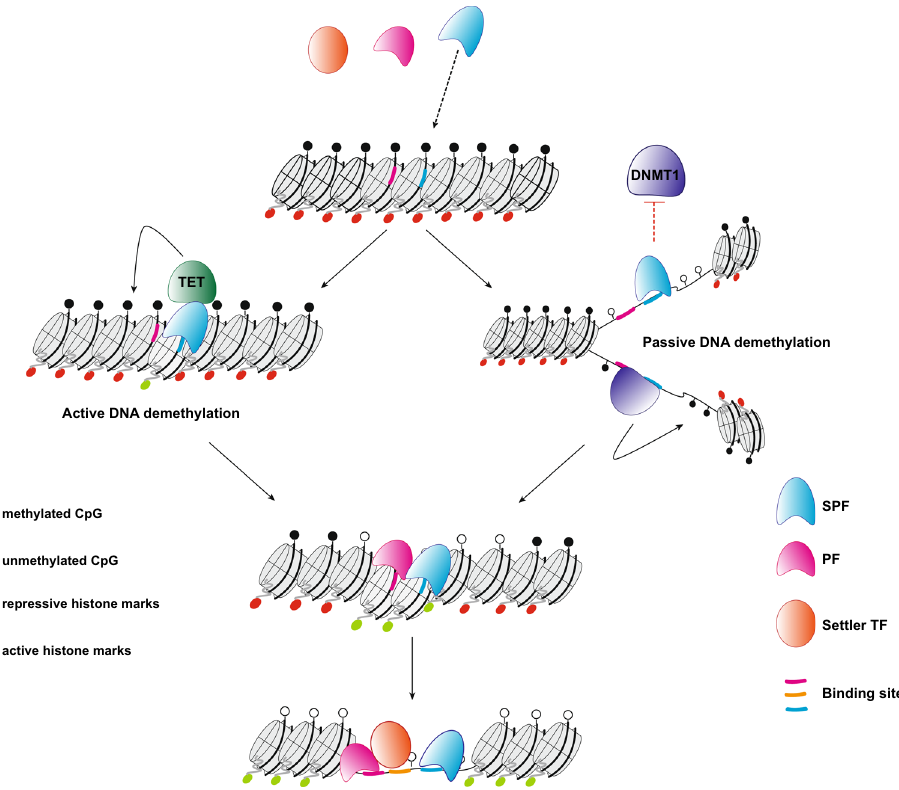
Fig. 8 Hierarchy of transcription factor binding. SPFs engage their target sequences in closed chromatin and in the presence of DNA methylation. Upon binding, most SPFs drive DNA demethylation through active processes, mainly mediated by the TET enzymes, while SOX2 leads to passive DNA demethylation. Loss of DNA methylation allows the binding of methylation-sensitive PFs. Nucleosome remodelling and deposition of histone modi fi cations associated with open chromatin regions, mediated by both SPFs and PFs, create a favourable environment for the binding of settler